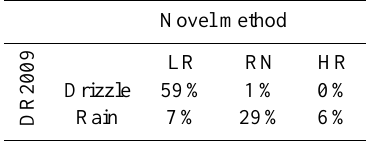
Table 4. Confusion matrix comparing the classification of liquid phase hydrometeor classes ( (cid:49)z < 0) obtained with the clustering method described in the paper and the output of the fuzzy-logic method DR2009, described in Appendix B. The classes of the novel method are light rain (LR), rain (RN), and heavy rain (HR). The el- ements M i,j of the matrix contain the percentage of liquid phase observations classified in the i th class of the first method and si- multaneously in the j th class of the second method. The data are obtained from 100 runs of the clustering